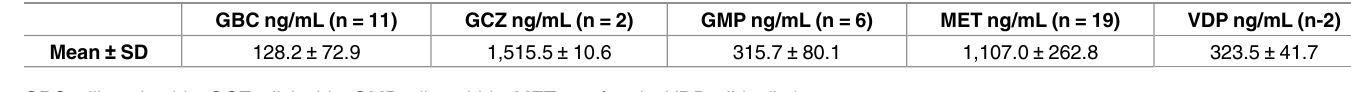
Table 4. Amounts of glibenclamide, gliclazide, glimepiride, metformin, and vildagliptin in plasma of diabetic patients (n = 40).